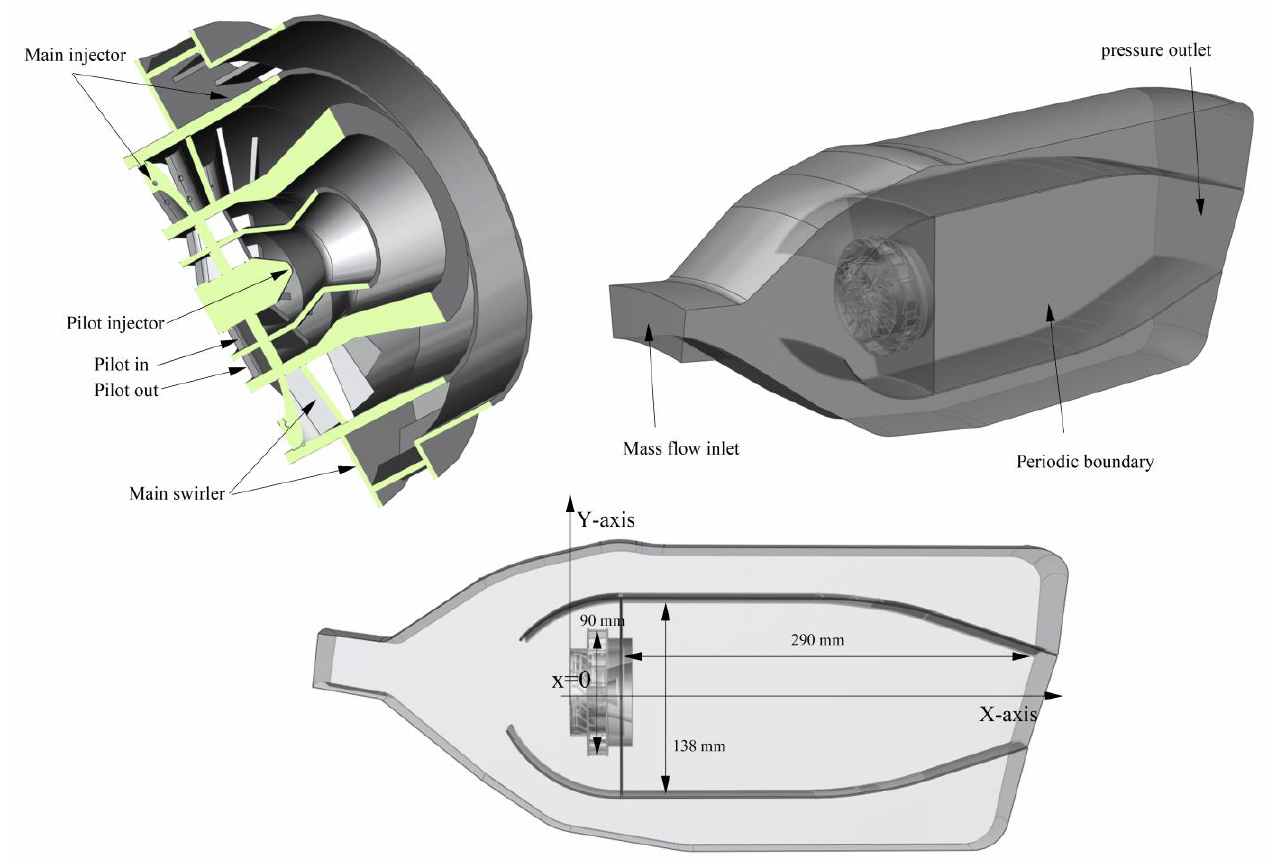
Figure 1. Schematic diagram of the calculation domain model.